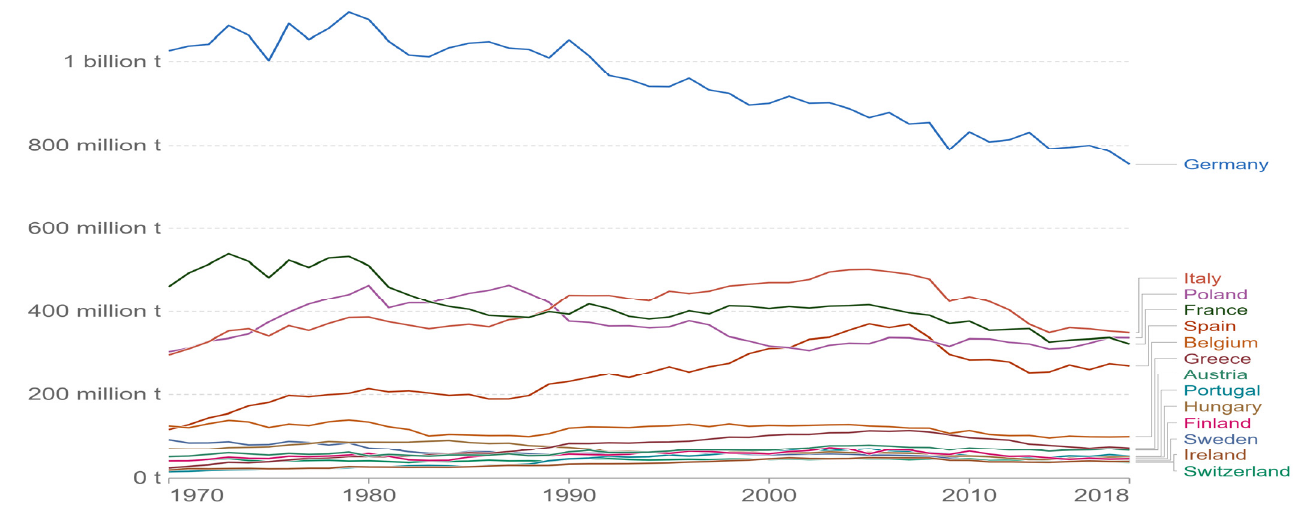
Figure 1. Annual growth of CO 2 emissions in EU countries (source: Our World